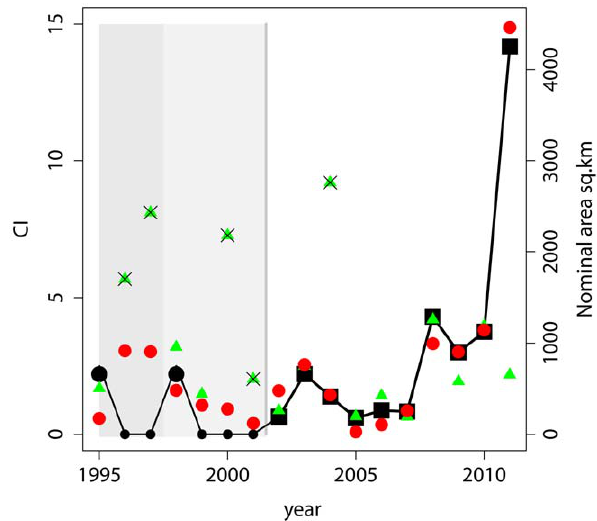
Figure 8. Observed and modeled CI. CI determined here (black squares) from 2002–2011. Period of projected CI is shown in light gray, with black circles giving projected CI based on reports of blooms or not. 1995 and 1998 blooms are assumed to be equal to 2003, other years are assumed zero (no bloom) based on lack of reports. Red circles are CI estimated from exponential Q model. Green triangles are CI from TP for June. Triangles with an X have ratio of TP June /TP March-May . 0.2. Dark gray shade marks time period when the models fail to predict occurrence or absence of blooms. doi:10.1371/journal.pone.0042444.g008 PLoS ONE |